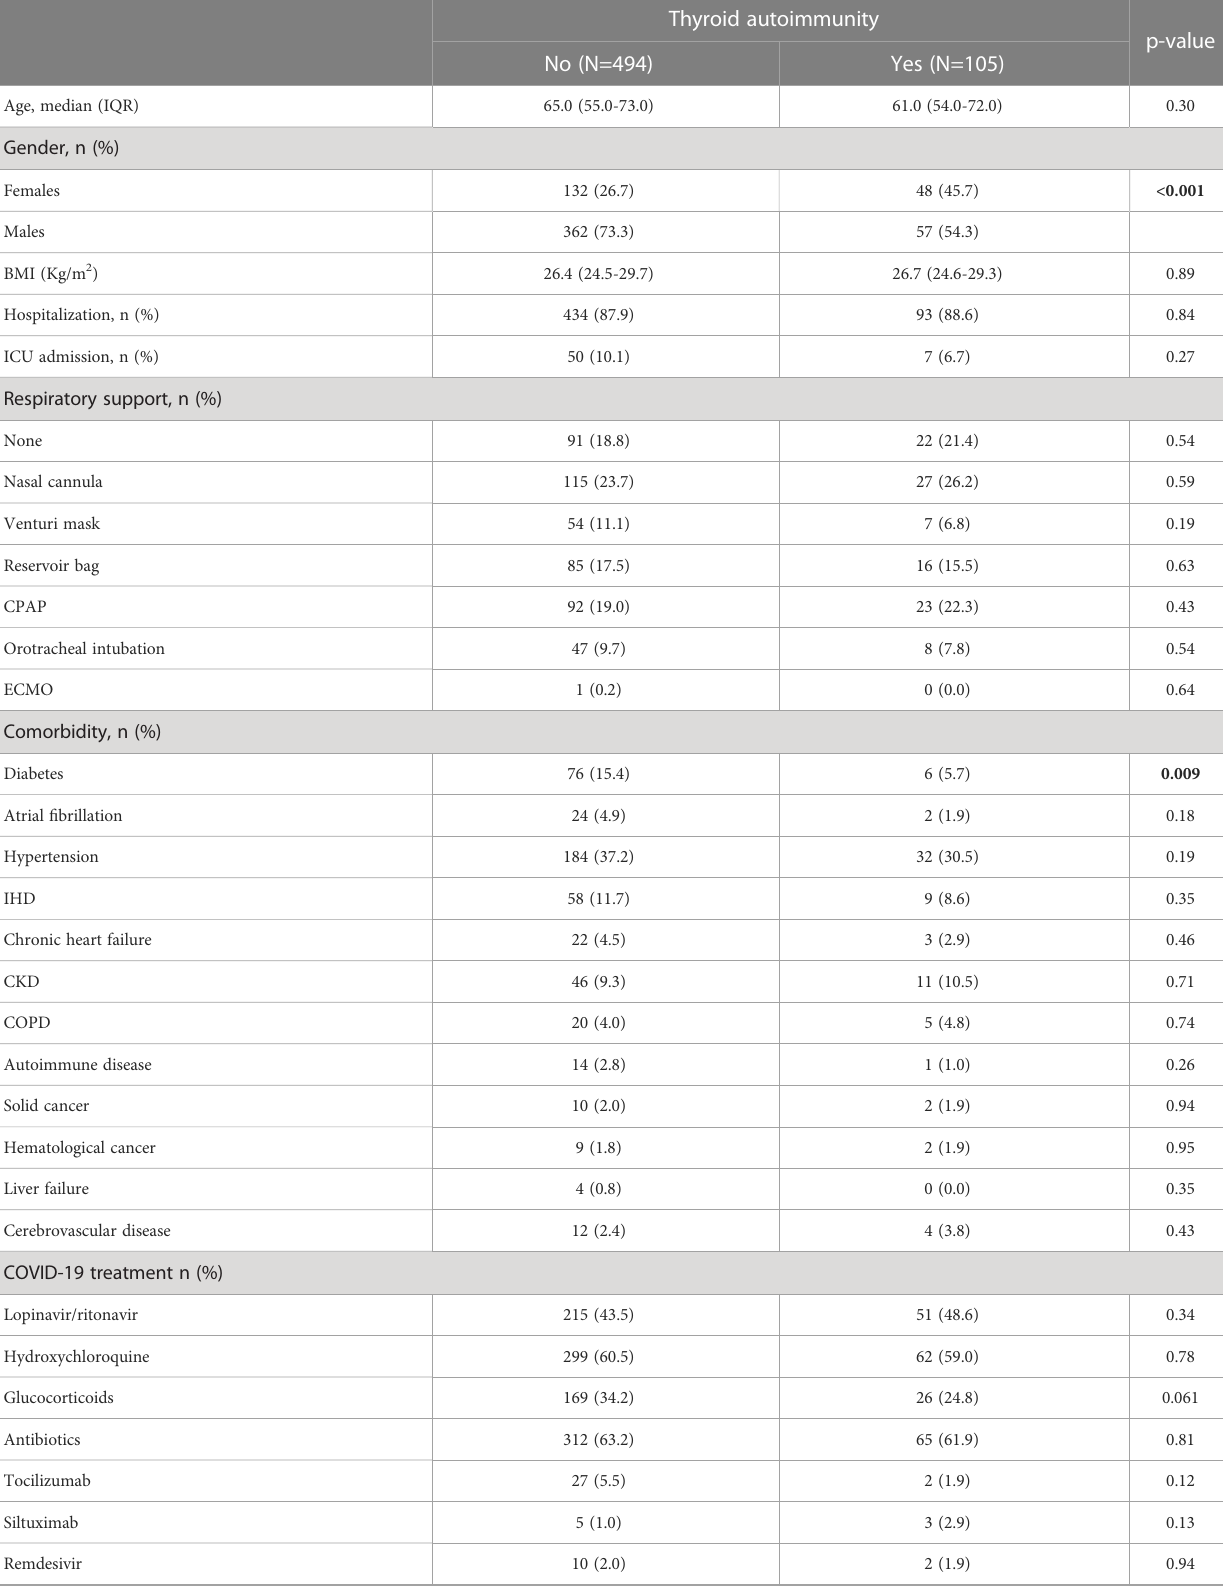
TABLE 1 Clinical characteristics of COVID-19 patients according to thyroid autoimmunity